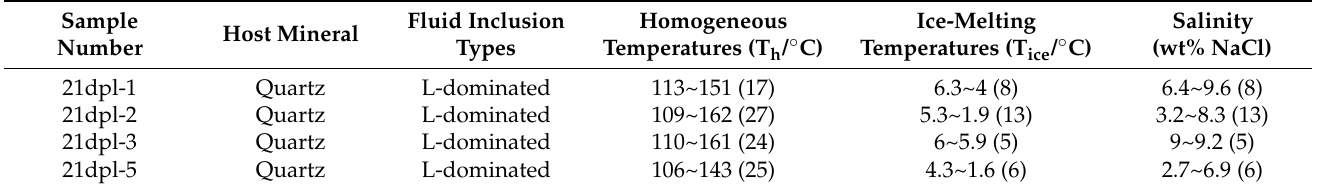
Table 2. Microthermometric data of the L-dominated fluid inclusions for the Dongpuzi gold deposit.